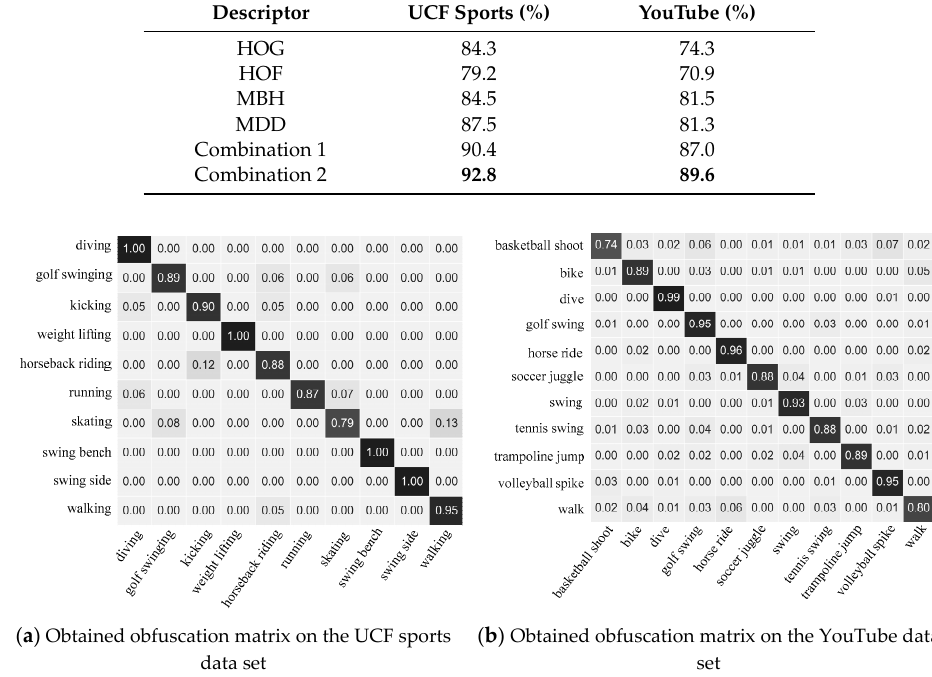
Figure 3. Obfuscation matrixes obtained by the algorithm in this paper on different data sets .